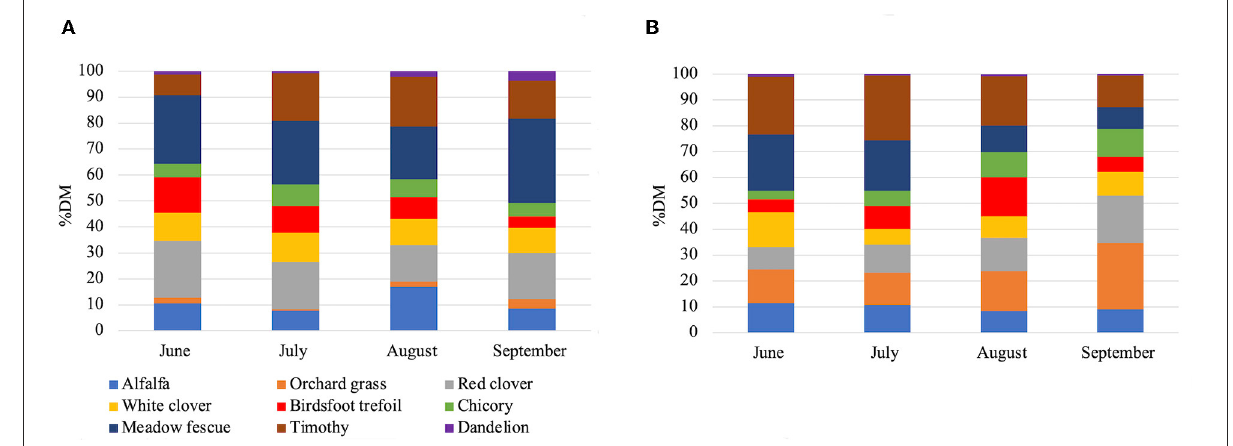
FIGURE1 Monthly botanical composition of the pasture in 2019 (A) and 2020 (B) in percentage of dry matter. DM, dry matter.